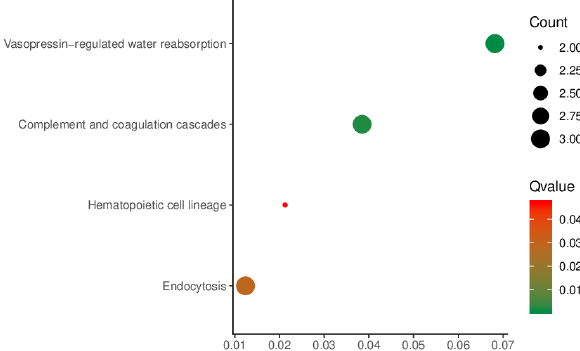
Figure 6: Bubble plot of KEGG pathway enrichment for FOLR1 and relevant